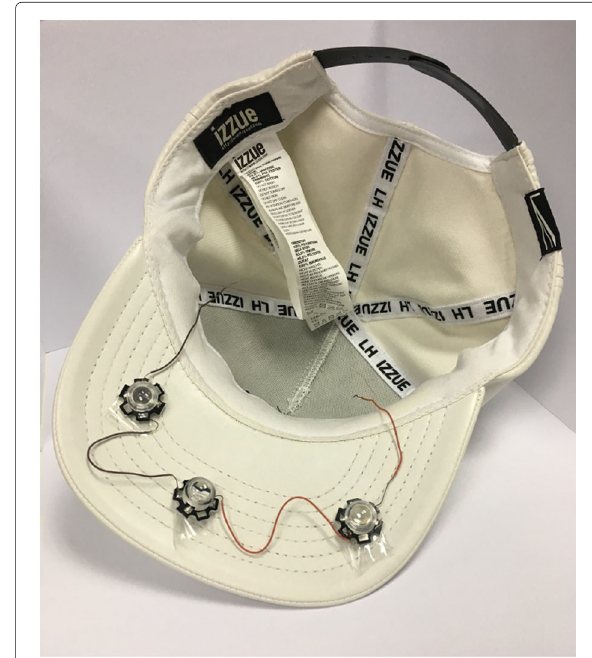
Fig. 6 Adversarial road signs valid in different view of angle Fig. 7 The cap mounting LEDs to launch